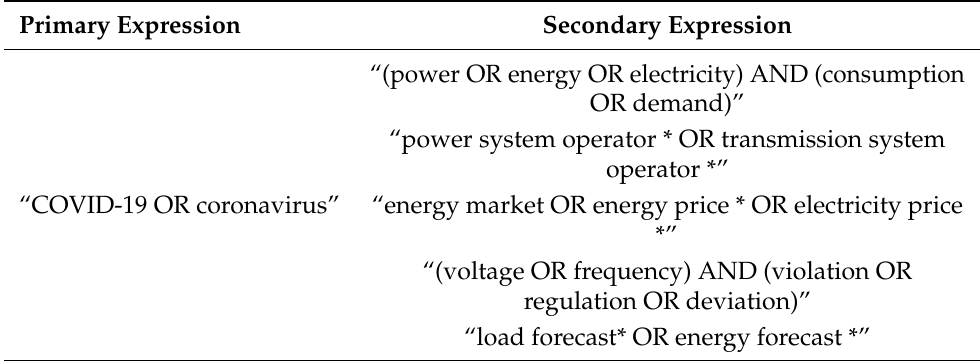
Table 3. Search expressions that were used in the literature review. Note that the asterisk is used as a wild-card, allowing the search-engine to capture multiple variations of a